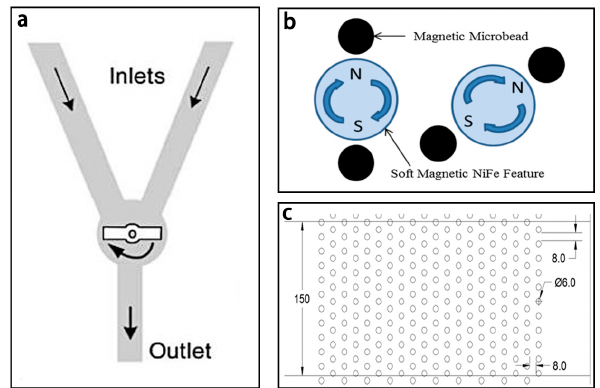
Figure 7. ( a ) Schematic of the magnetic stirring micromixer; ( b ) Schematic of the magnetic microbeads attracted to the poles of the NiFe feature; ( c ) Schematic of the microfluidic channel with its floor patterned with NiFe features. Reproduced with permission from [54,84].